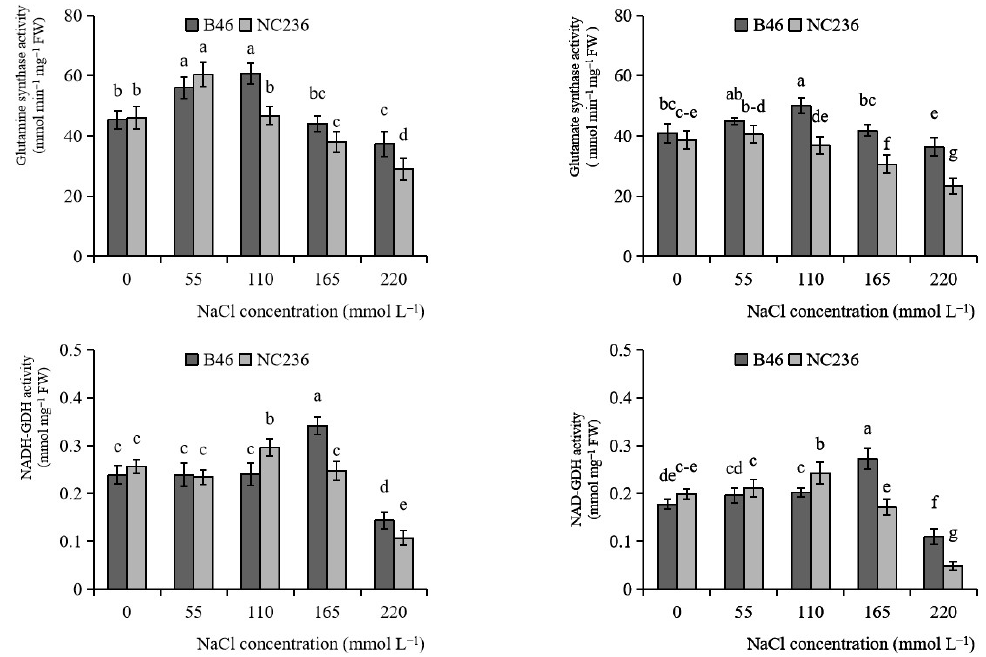
Figure 7. Effects of salt stress on the activities of glutamine synthase, glutamate synthase, NADH- GDH, and NAD-GDH in maize leaves. Data are expressed as mean ± standard deviation. Different letters within the same column indicate significant difference at the 5% level.